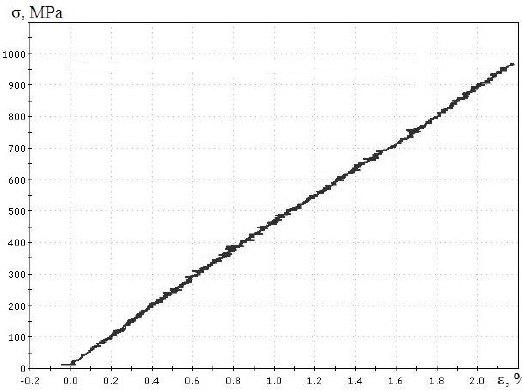
Figure 4: The appearance of typical diagram of unidirectional fiberglass Direct "E" roving 0.7 - orthophthalic polyester resin 0.3 deformation in tensile